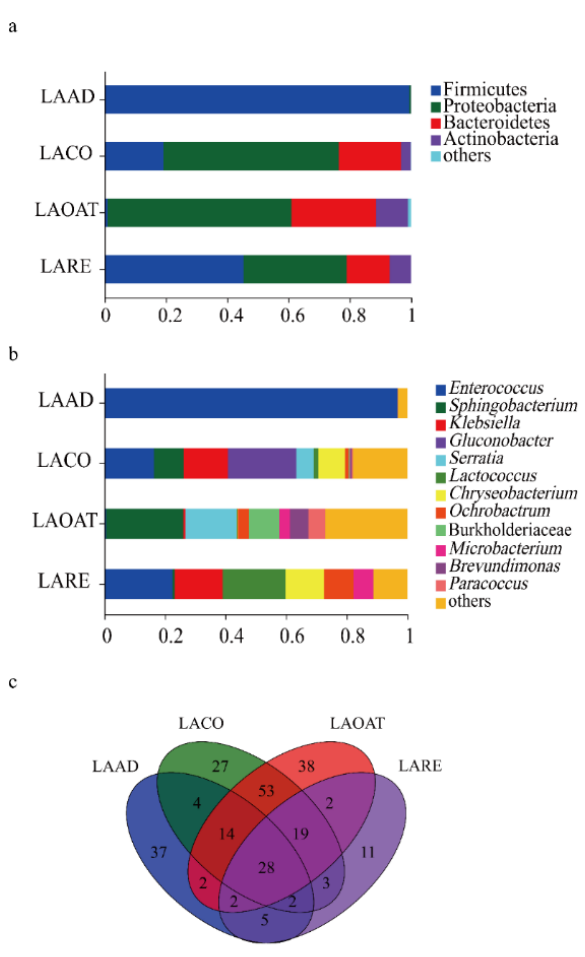
Figure 3. The relative abundance and composition of gut bacterial communities in C. suppresallis . ( a ) Relative abundance of bacterial communities at the phylum level. ( b ) Bacterial community relative abundance at the genus level. ( c ) Venn diagram of the shared and unique genera among different diet groups. A few phyla and genera with a relative abundance lower than 0.05% of the total sequences were referred to as “others.” LAAD: larvae fed on an artificial diet, LACO: larvae fed on a corn diet, LARE: larvae fed on a rice diet, and LAOAT: larvae fed on a water oat diet.